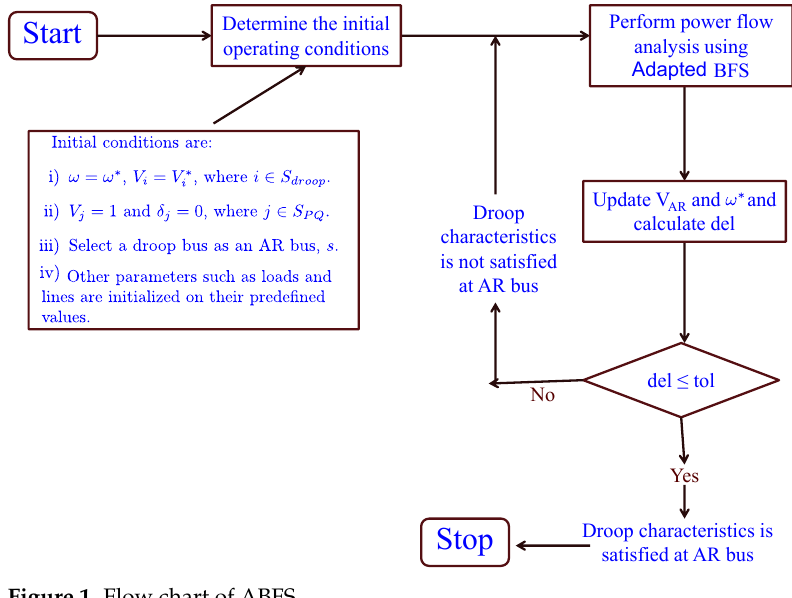
Figure 1. Flow chart of